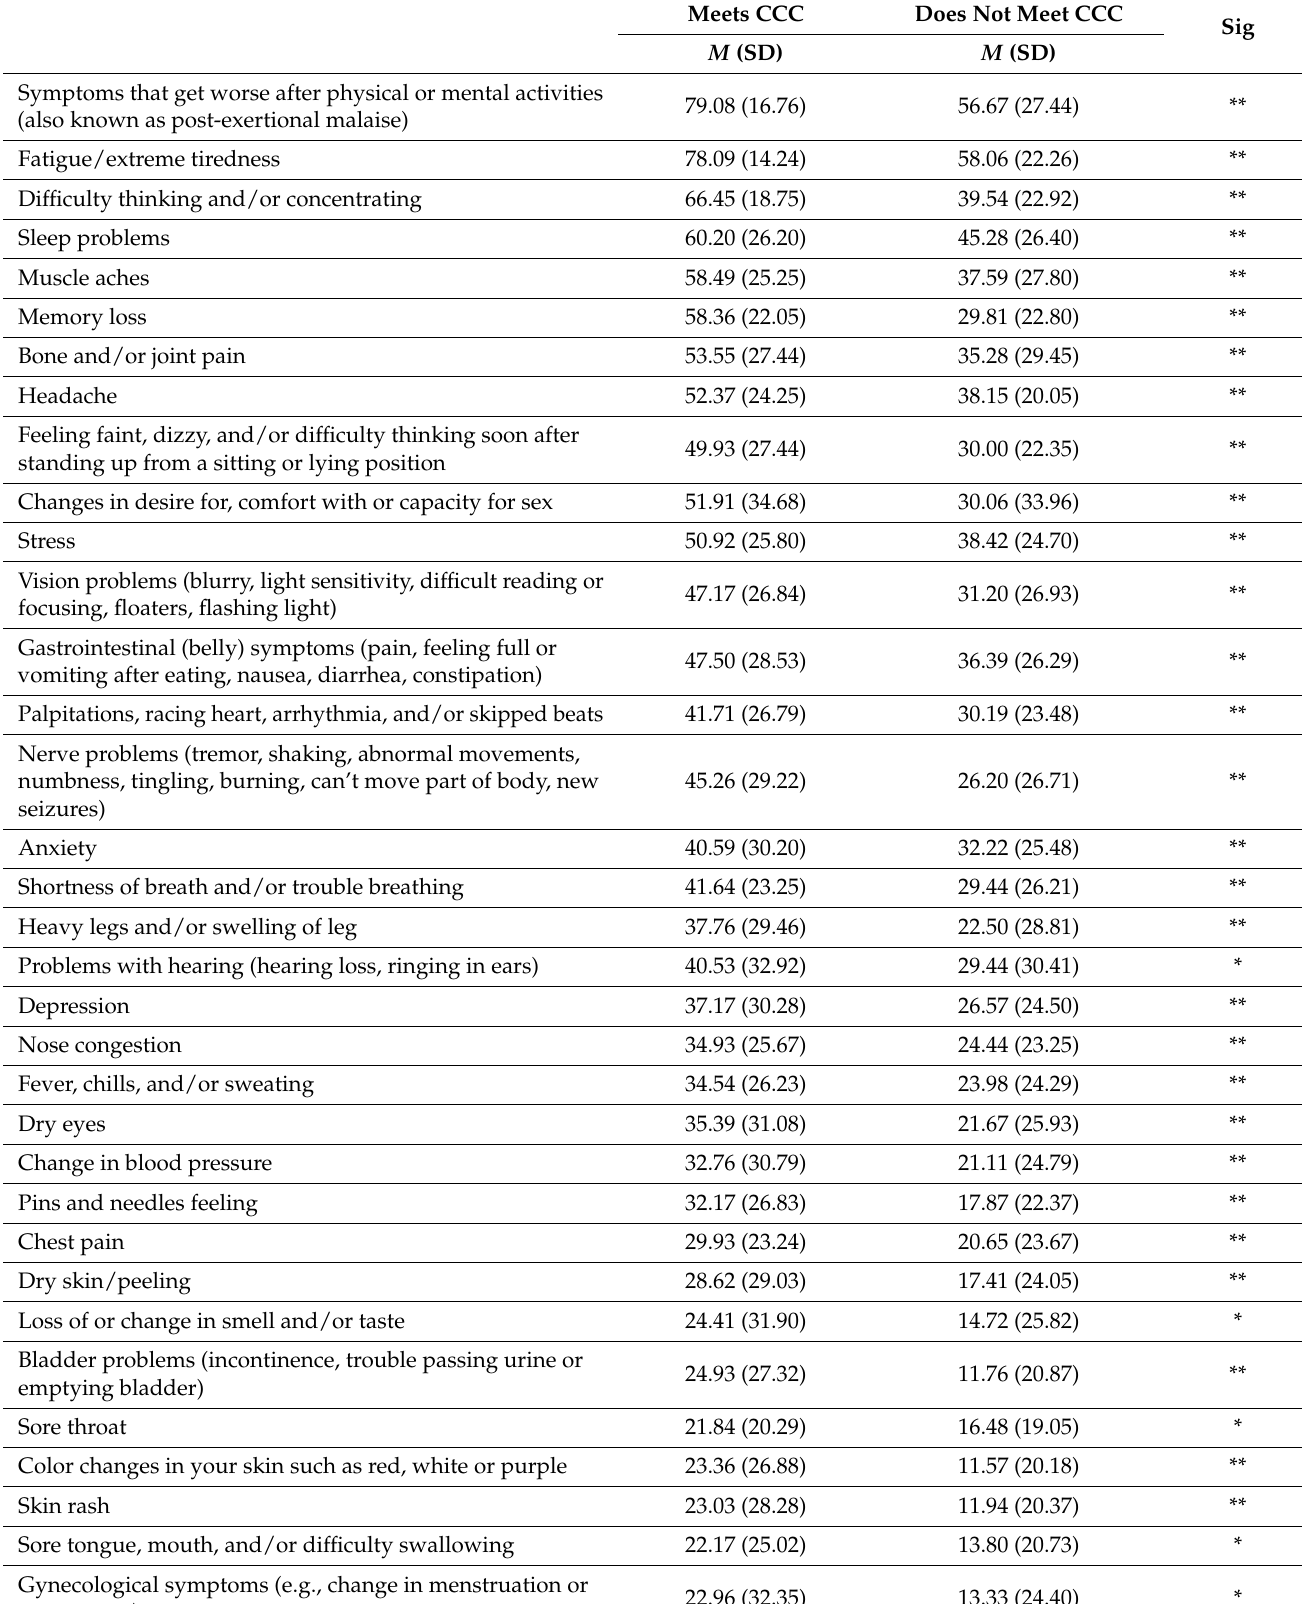
Table 2. DSQ-COVID symptom means and standard